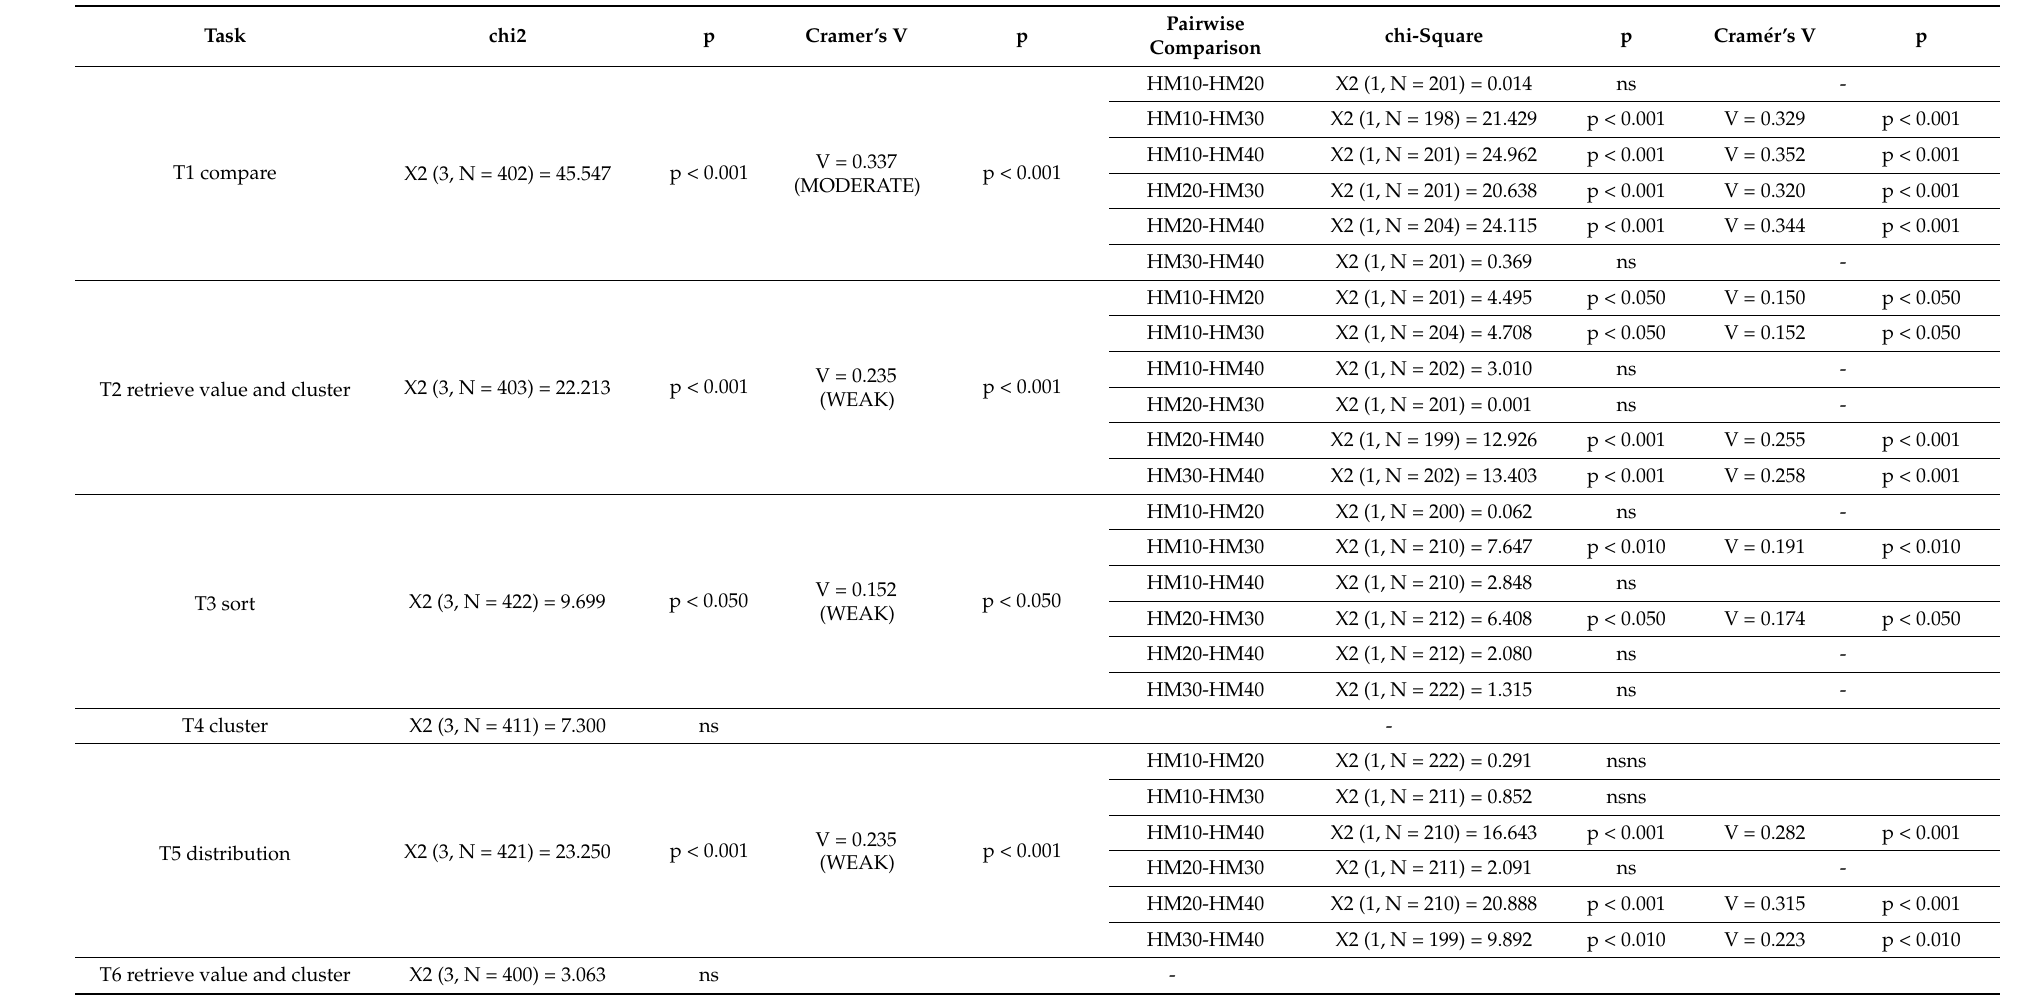
Table 3. Inferential statistics for answer accuracy between participants using the four tested heat